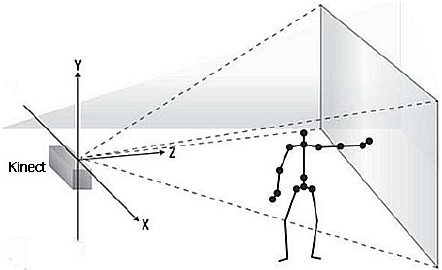
Figure 1. World coordinates of the Kinect sensor-based